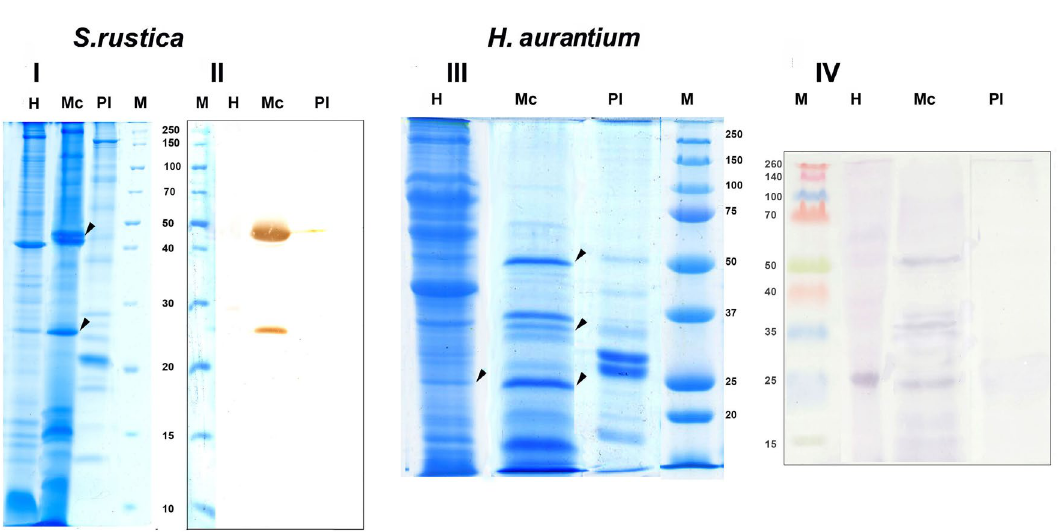
Figure 2. Electrophoresis and immunoblot of S. rustica and H. aurantium blood cell proteins . I, III—SDS- electrophoresis; II, IV—immunoblot. Hyalinocytes (H), morula cells (Mc), blood plasma (Pl), protein ladder (M). Protein ladder of panel II stained with amido-black. Arrows indicate protein bands immunoreactive to AB to p48, excised from the gel for MALDI excised from the gel (Fig. 2, I, III, arrows) according to the Western blot staining for further mass spectrometric analysis. Sequence of Tuphoxins . Protein bands excised from the gel were digested by trypsin. The primary amino acid (aa) sequence of tryptic fragments was deduced by MALDI MS–MS and further used to find full-length sequences in protein databases. We used the translation of de novo sequenced draft transcriptome of blood cells belonging to S. rustica (BioProject ID:PRJNA772663) and whole body transcriptome available for H. auran-